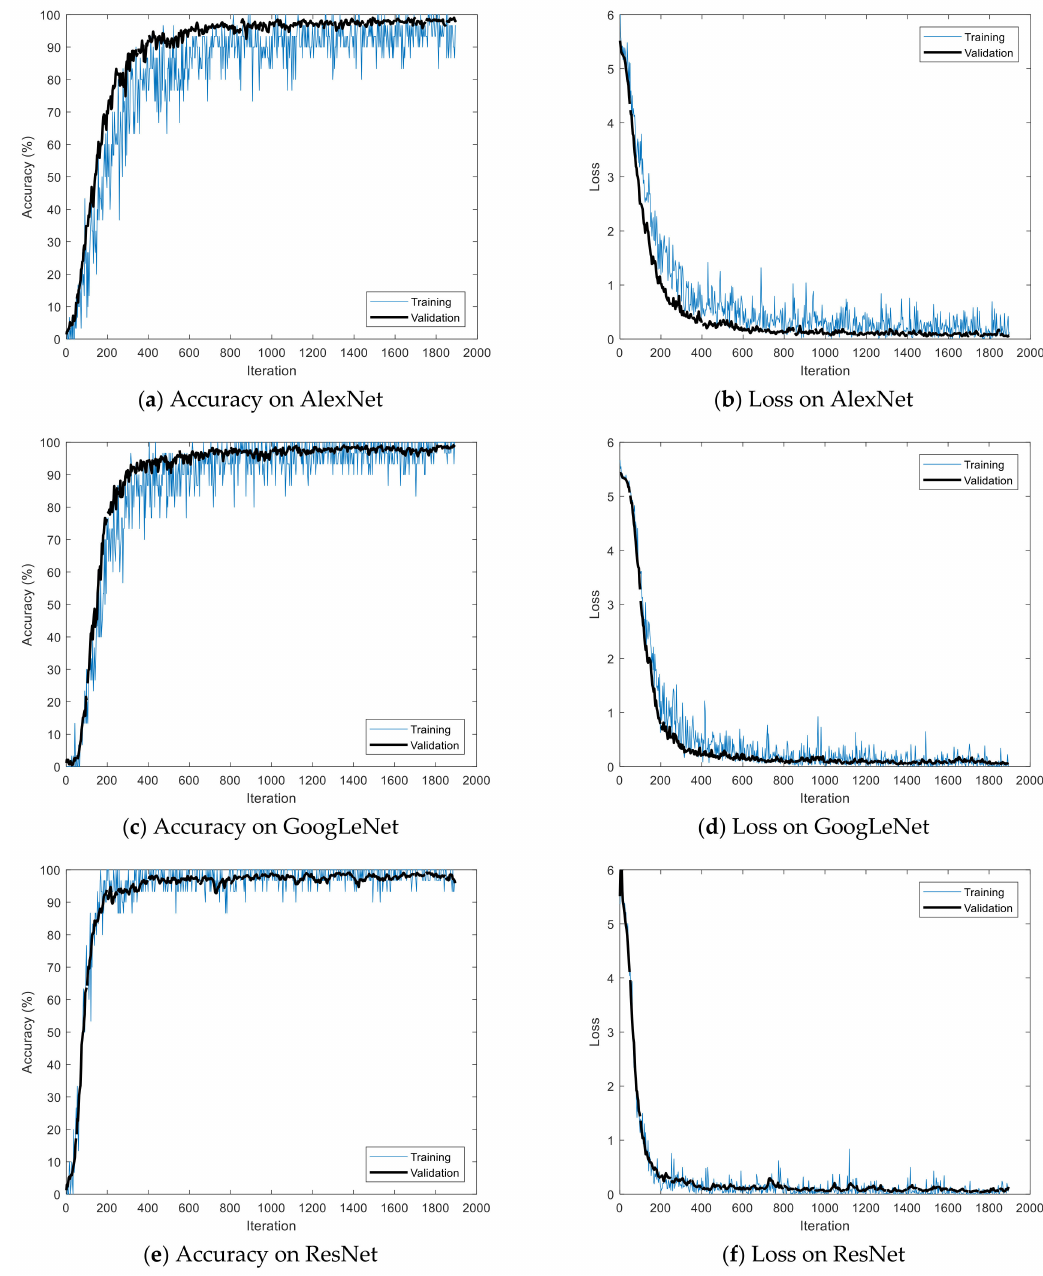
Figure 10. Training processes in